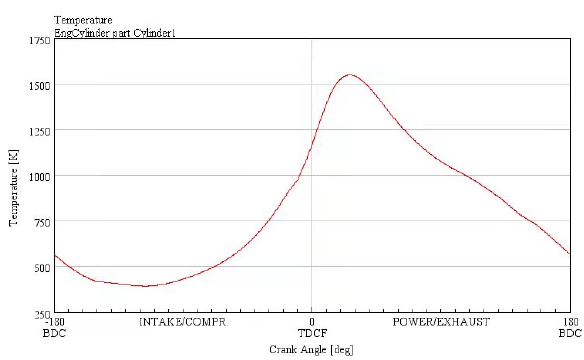
Figure 4. Temperature curve in cylinder.